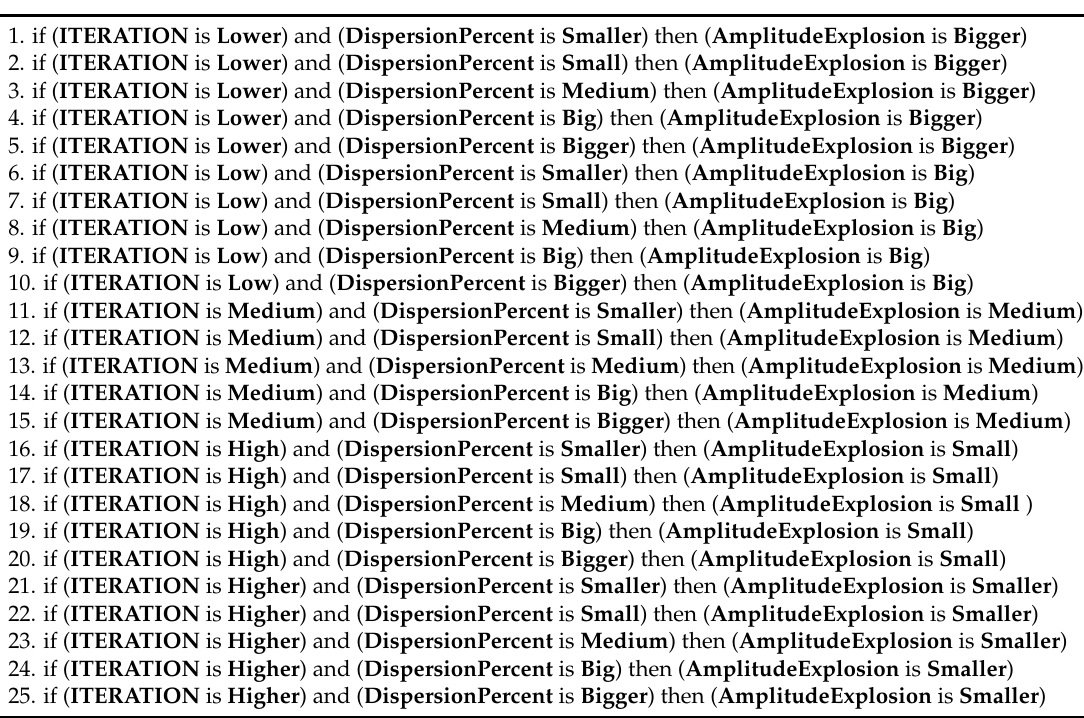
Table 1. Fuzzy rules of DPIFFWA-I.